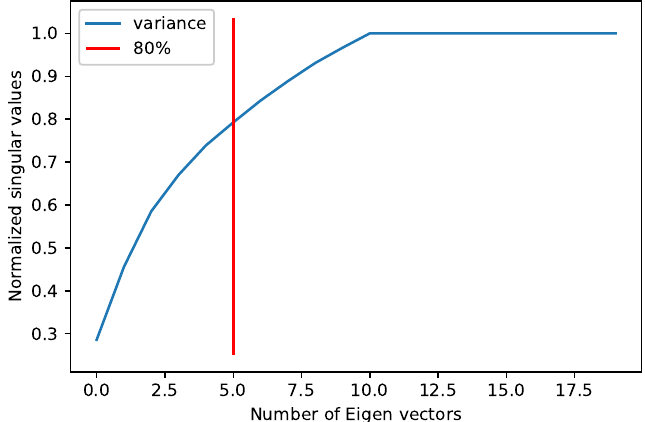
Figure 5. The variance between the data features. Eighty percent of the variance in the training data was captured by five PCA components, corresponding to the largest singular values.